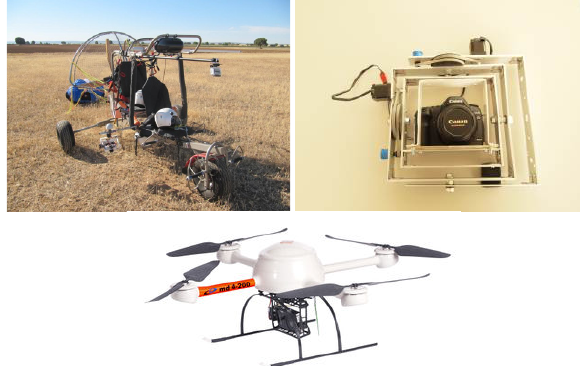
Figure 1. Paratrike employed (up-left); detail of the stabilization platform “MUSAS” (up-right) and UAV used in those complex areas (down).